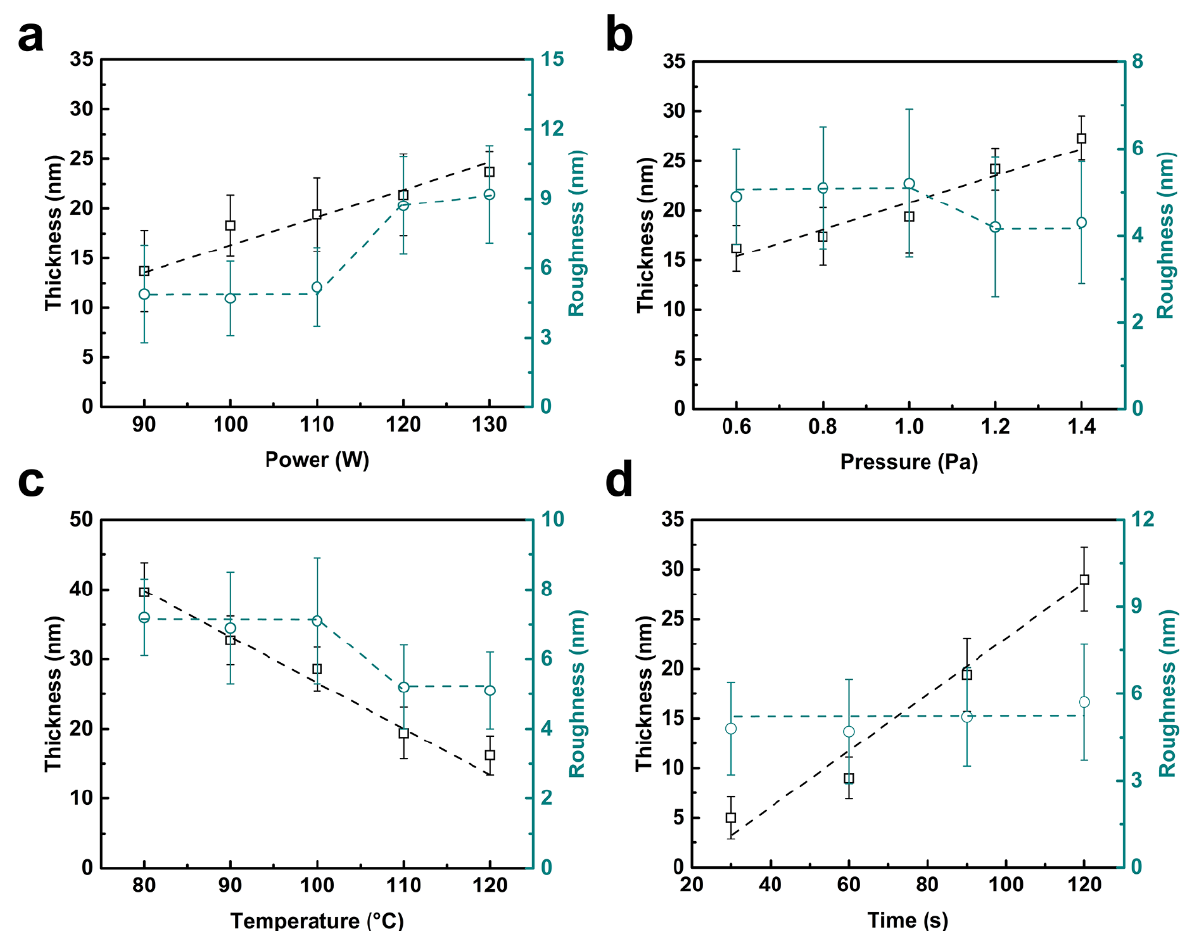
Figure 1. Optimization of sputtered PTFE films. Effect of sputtering power ( a ), chamber pressure ( b ), substrate temperature ( c ), and deposition time ( d ) on film thickness and surface roughness. Each of the data points is based on at least 5 measurements (see Figures S1 − S4 in the Supplemental Information for typical surface profiles). The broken lines are used to assist view only.